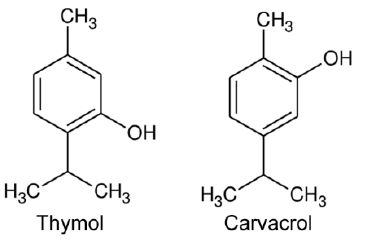
Figure 9. Isopropylmethylphenol structure.